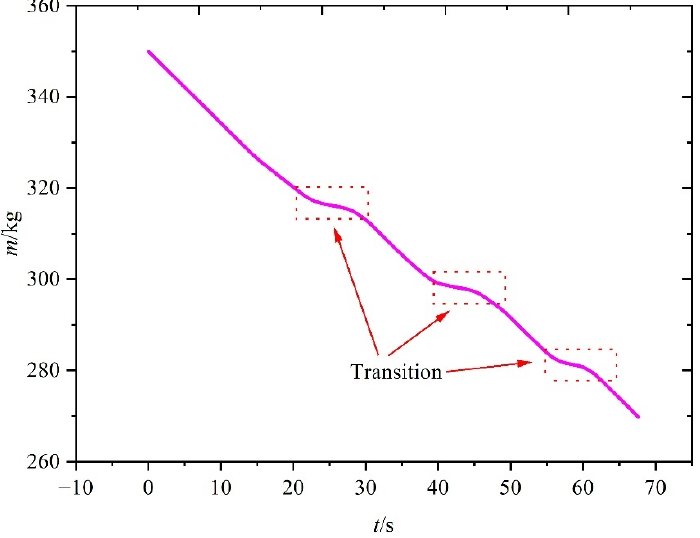
Figure 10. Vehicle mass in the second scenario vs. time.